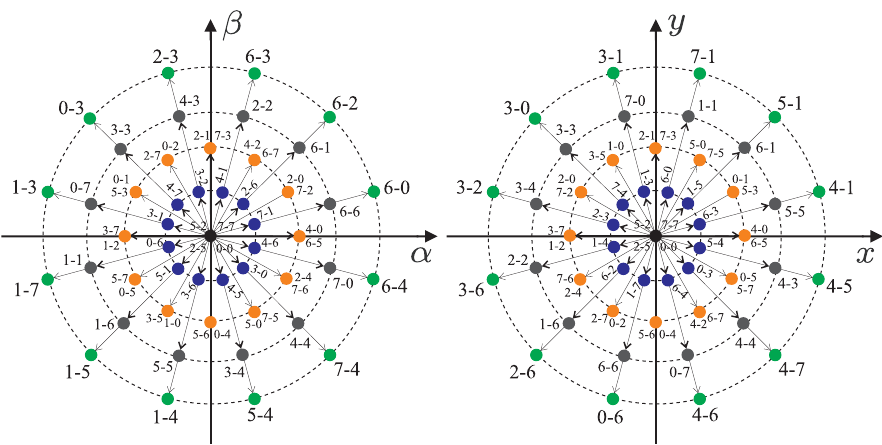
Figure 2. Mapping of the space vectors in the ( α - β )-( x - y ) frame for a two-level six-phase